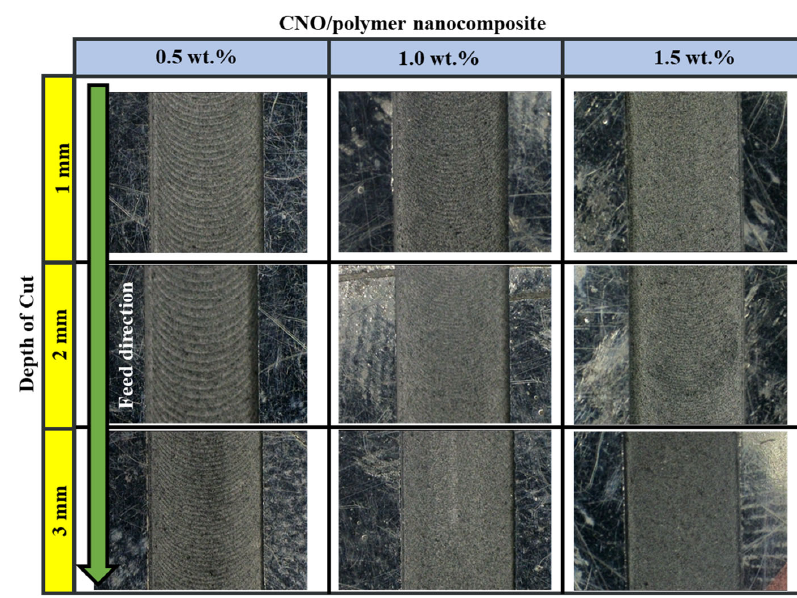
Fig. 3. Machined samples (Milling slots)